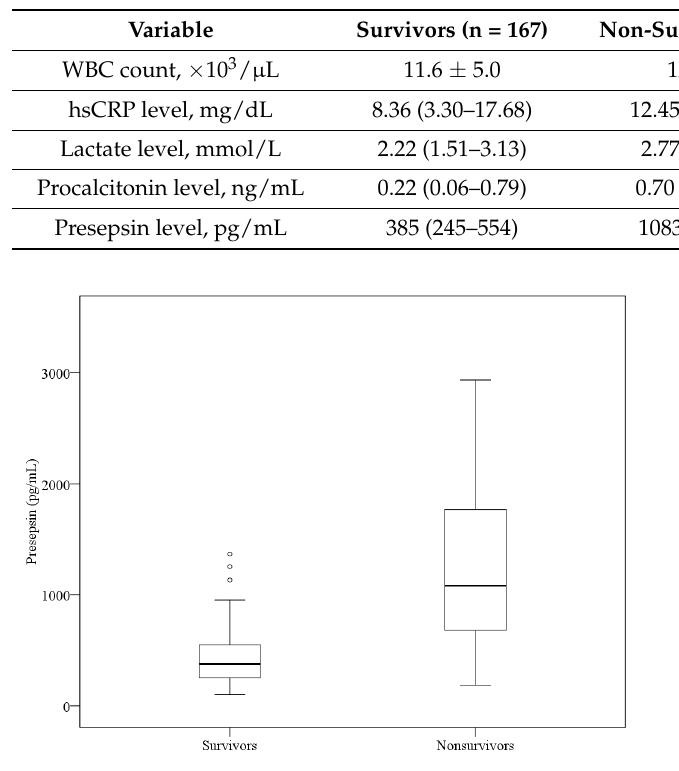
Figure 2. Difference of presepsin levels between survivors and non-survivors.